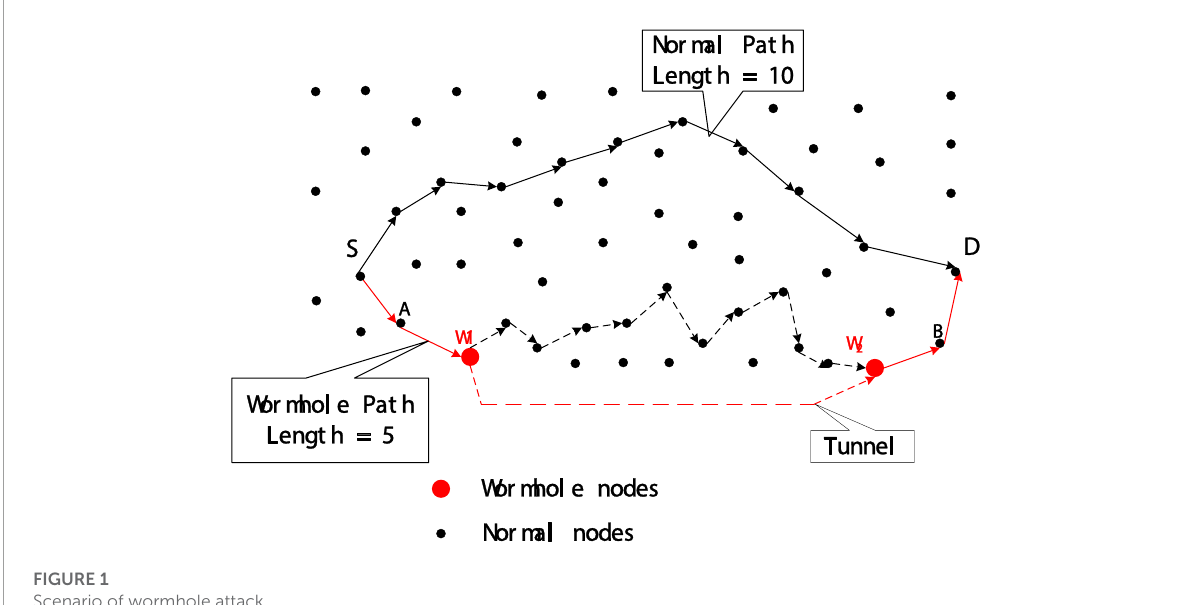
FIGURE 1 Scenario of wormhole